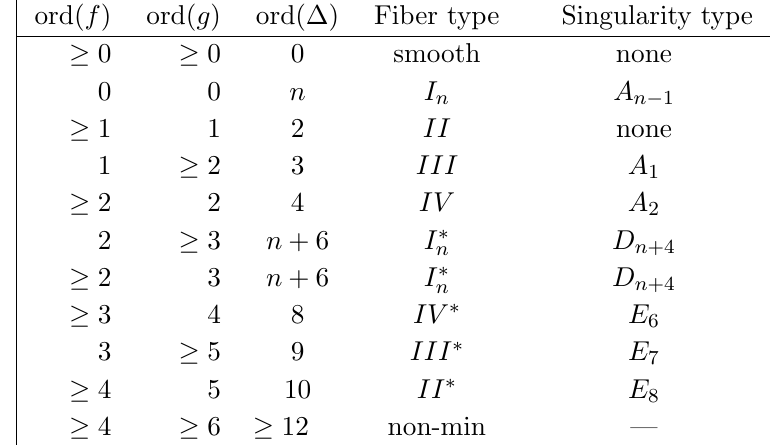
Table 7 . The Kodaira classi(cid:12)cation of